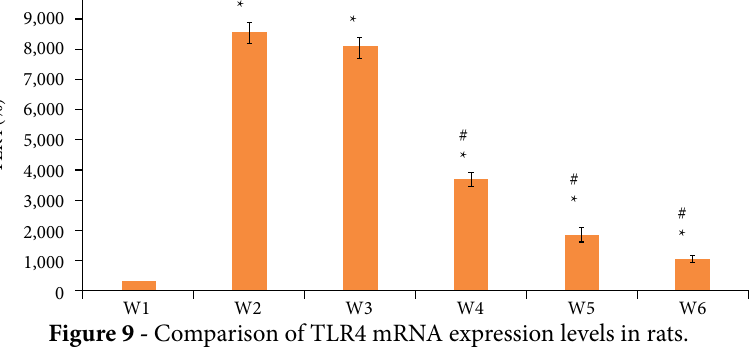
Figure 9 - Comparison of TLR4 mRNA expression levels in rats.